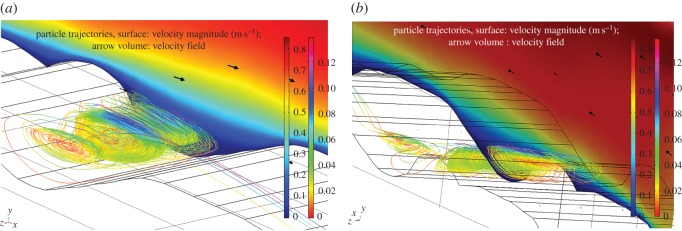
Detail of three-dimensional particle orbits in eddy (cf. figure 14). Single particle density 3000 kg m−3 (Opx), size 10 mm, magma density 2500 kg m−3, viscosity 1 Pa s. (a) Roll-geometry is clearly defined by the particle streamlines which show cross-stream variation in rotational velocity. Note some particles ejected back into the main flow. (b) Same eddy viewed from a different perspective shows how the particle orbital geometry extends across the Sill floor normal to the main flow field (shown as a two-dimensional slice). The model eddy structures correspond to a field scale of 1–10 metres.